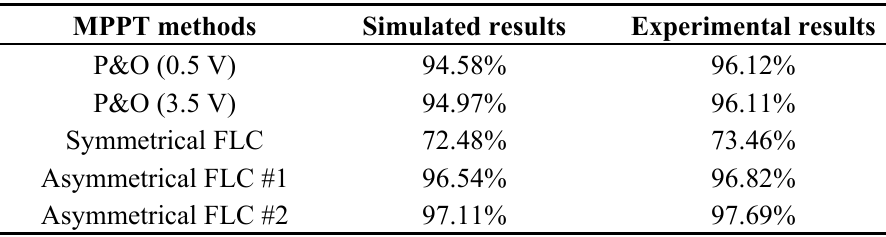
Table 7. Simulated and experimental fitness